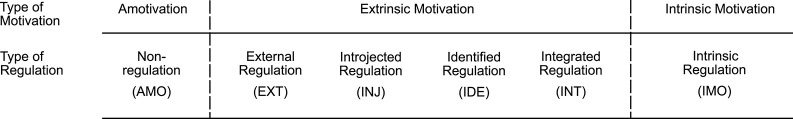
The six types of motivational regulation as posited by Self-Determination Theory. Ranging from the least self-determined (amotivation) to the most self-determined regulation (intrinsic motivation). Figure adapted from Deci and Ryan (2002), p. 16.